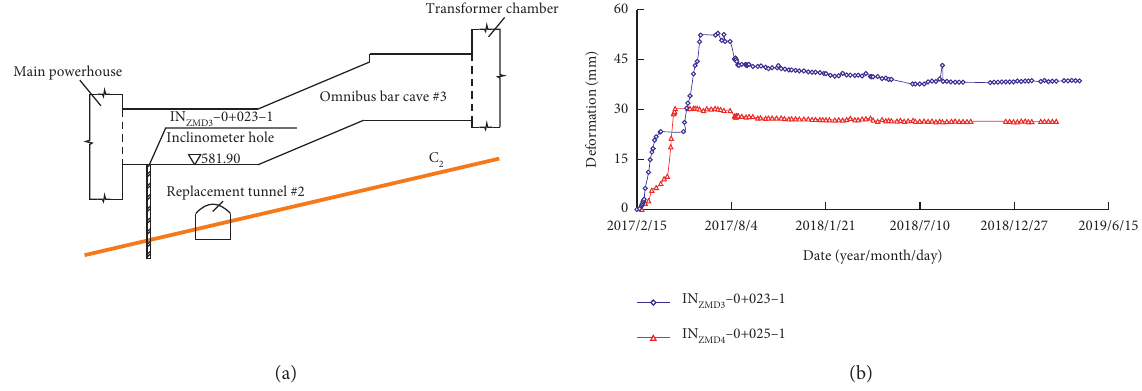
Figure 7: The layout of the inclinometer and the measured deformation-time curves (IN refers to the number of inclinometers): (a) layout of the inclinometer in omnibus bar cave #3; (b) shear deformation deformation-time curves measured by the inclinometers in the omnibus bar